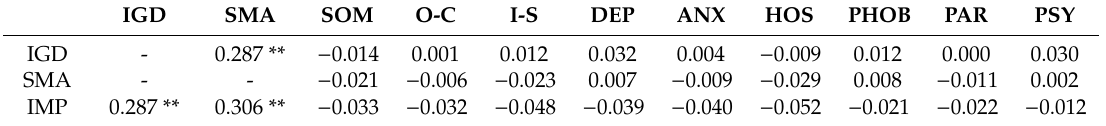
Table 2. Bivariate correlations between the variables of interest for the total sample.